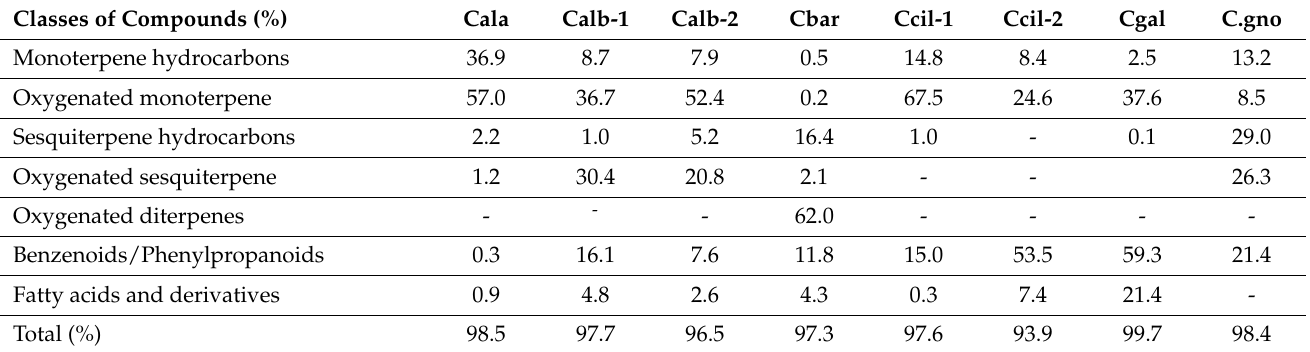
Table 7. Classes of compounds identified in Catasetum specimens used in the multivariate statisti- cal